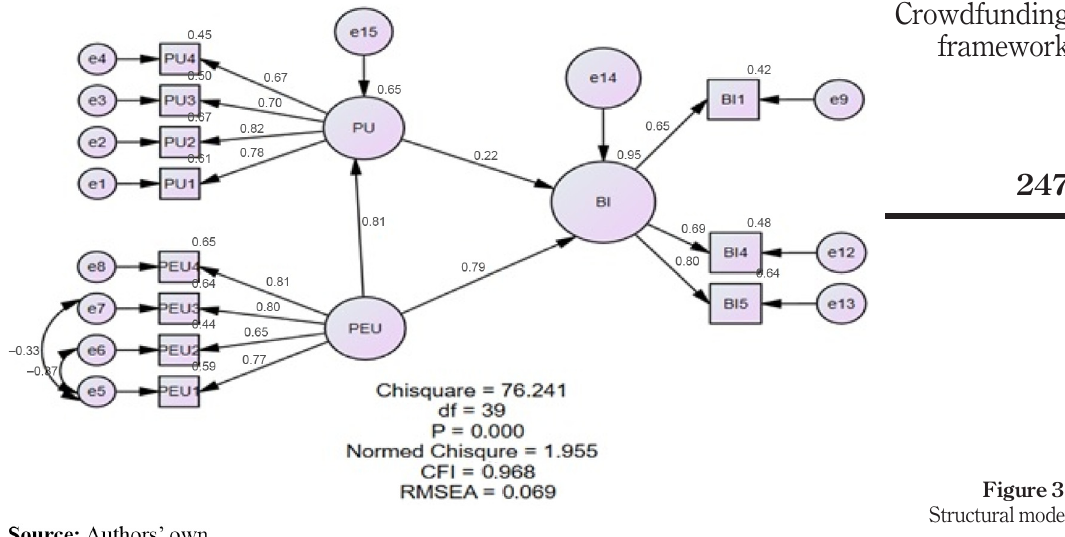
Figure 3. Structural